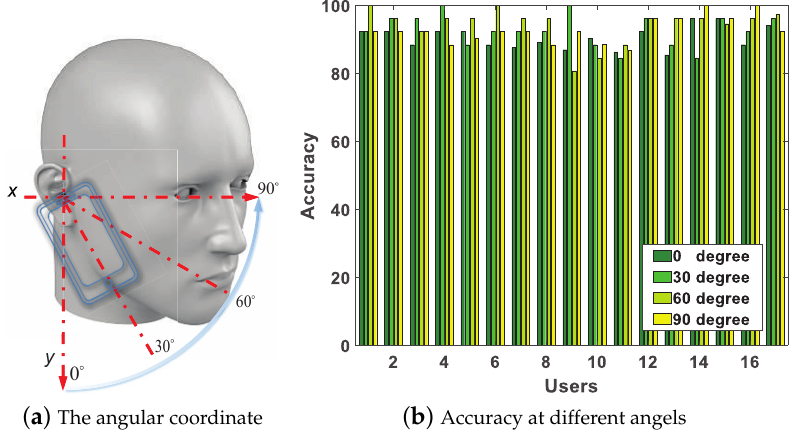
Figure 12. Impact of different angels.